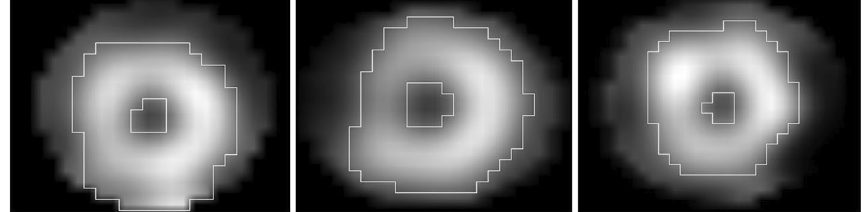
Fig. 2 Myocardial ROI in the uncorrected clinical SPECT images of three patients. The ROI was defined as the pixels whose counts exceeded 45% of the maximal pixel